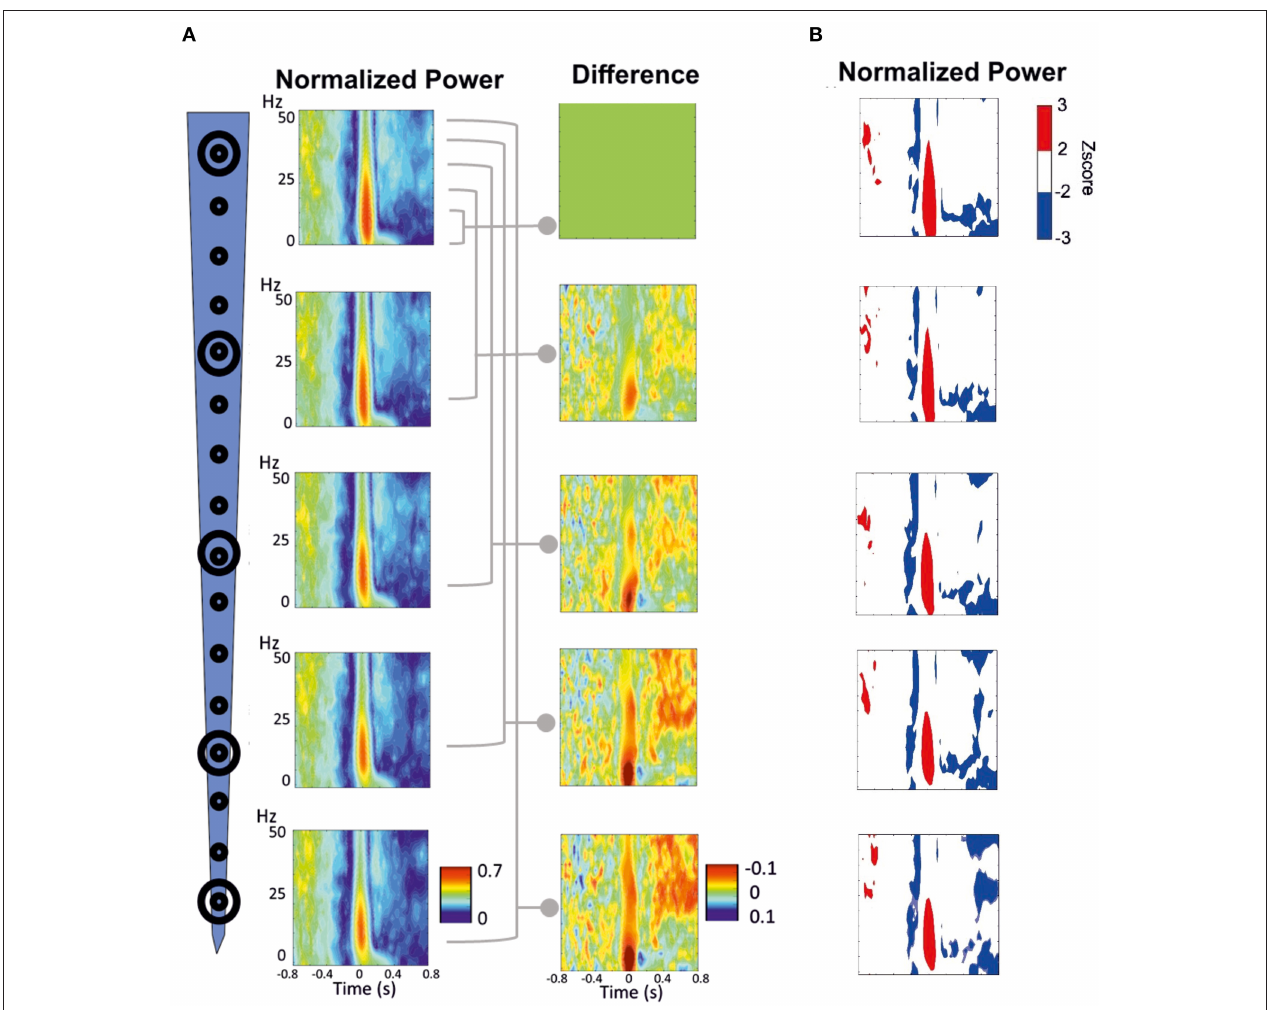
FIGURE 7 | Time-frequency response (TFR) was performed around the peak of IIS (T0). (A) Normalized grand-average TFR power for different channels at different depths. The power differences between each of the four channels vs. the most superficial channel are plotted on the right. (B) Z-score normalized results, highlighting the pattern of decrease-increase-decrease in the power frequency surrounding the IIS. An increase in synchrony is represented in red. A decrease in synchrony is plotted in blue.